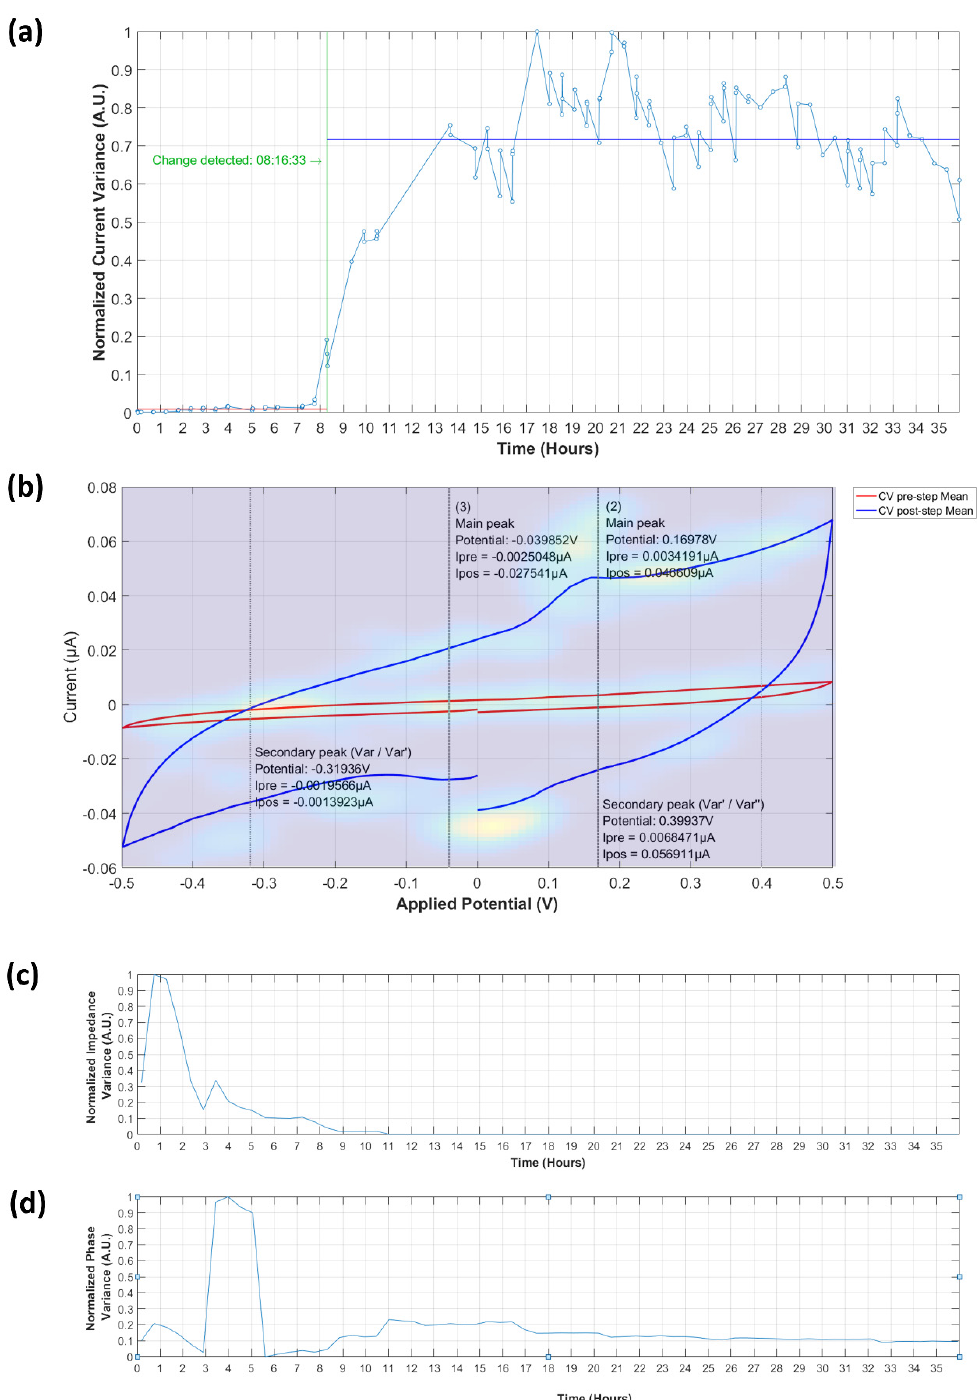
Figure A6. Recorded electrochemical response of a colonized microsystem for a ~36 h experiment. ( a ) Normalized current variance vs. time. Detected current peaks are indicated (peaks from variance to its first derivative ratio are indicated as Var/Var’, peaks from first derivative to second derivative ratio are indicated as Var’/Var’’. The current values at each peak are indicated for the mean before colonization event as I pre and for the mean after colonization event as I pos ). Note the characteristical step shape. ( b ) Recorded CV with calculated peaks and heatmap of detected peaks, where yellow represents a high concentration, and dark blue no peak. ( c ) Normalized impedance variance vs. time. ( d ) Normalized phase variance vs. time.